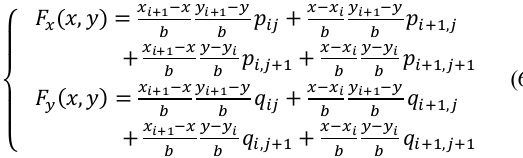
Figure 1. Wavelet analyses